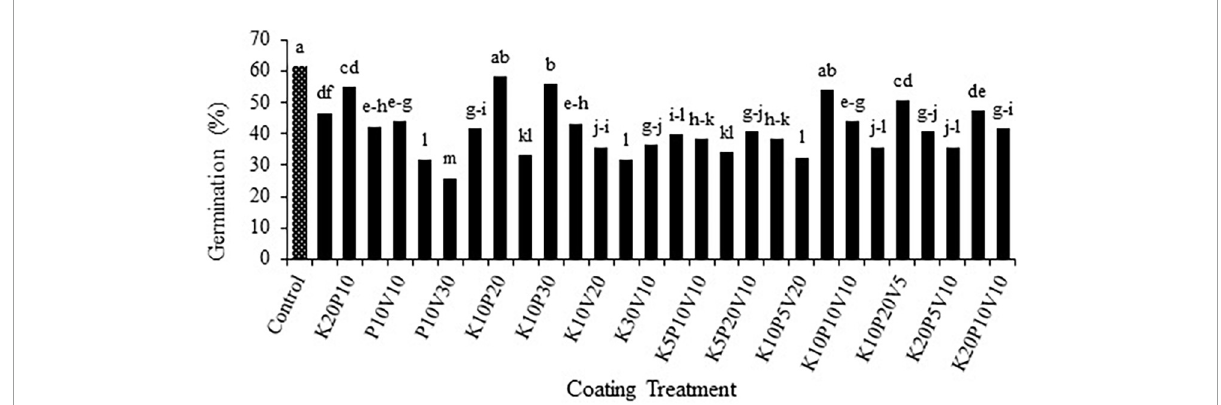
FIGURE1 Mean comparison of the effect of seed coating on germination percentage of anise seeds. Means with the same letter are not significantly different according to the HSD test at P = 0.05. K, kaolin; V, vermiculite; P, perlite.